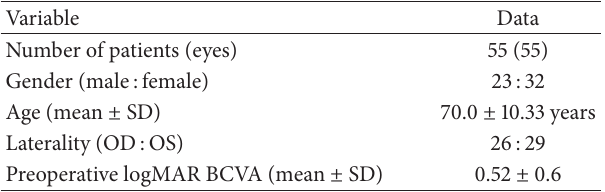
Table 1: Demographic data and preoperative clinical features.